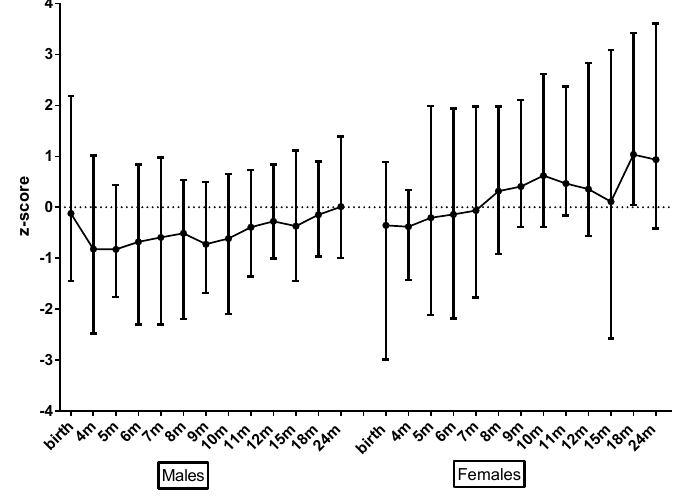
Figure 3. Mean female length z-scores for PKU vs. control groups by age.